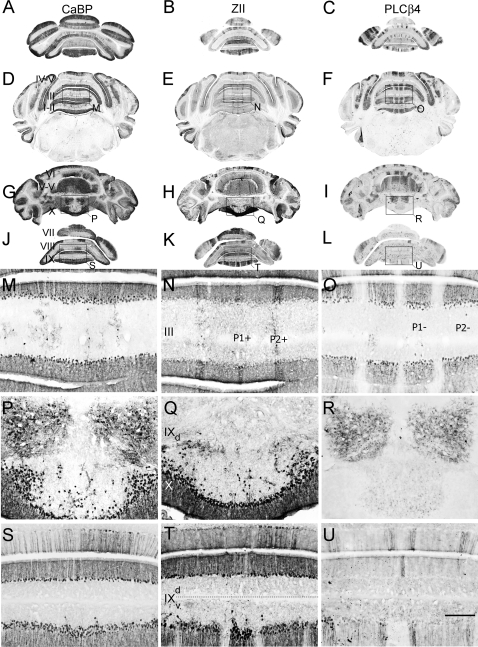
Purkinje cell ectopia is aligned with parasagittal organization in the aporER2 null cerebellum.A series of transverse cryosections through adult wild type (A–C) or Apoer2 null (D–R) cerebella immunostained with antibodies against calbindin (CaBP-A, D, G, J, M, P), zebrin II (ZII-B, E, H, K, N, Q) or phospholipase Cß4 (PLCß4-C, F, I, L, O, R). Sections from the Apoer2 null cerebellum are serial (zebrin II-calbindin-PLCß4). Boxes in D–I indicate areas where higher-magnification photomicrographs are presented below as indicated by the label. High power views of anterior cerebella immunostained with CaBP (M) reveal that ectopic Purkinje cells are restricted to discrete parasagittal domains. Immunostaining with ZII and PLCß4 in neighboring sections reveals that these ectopic cells are composed of discrete and non-overlapping stripes of ectopic Purkinje cells (N, O). Ectopic Purkinje cells in the PZ (lobules VIII and dorsal IX) are from the zebrin II-negative subset (compare Q, R). Purkinje cell ectopia in the nodular zone (NZ) is limited to ZII positive Purkinje cells (S–U). Dotted line in panel T marks the approximate dorsoventral boundary within lobule IX between the posterior zone (including the dorsal half of lobule IX) and nodular zone (ventral IX and X). The transition between PZ and NZ in lobule IX highlights the differing characteristics of ectopic Purkinje cells in the NZ (misaligned ZII-positive) and PZ (ectopic clusters of ZII-negative Purkinje cells). P1+ and P2+ denote zebrin II-positive/PLCß4-negative Purkinje cell stripes, while P1- and P2- label zebrin II-negative/PLCß4-positive Purkinje cell stripes. Roman numerals indicate lobules. Scale bar in R = 1 mm for A–I and 250 µm for J–R.